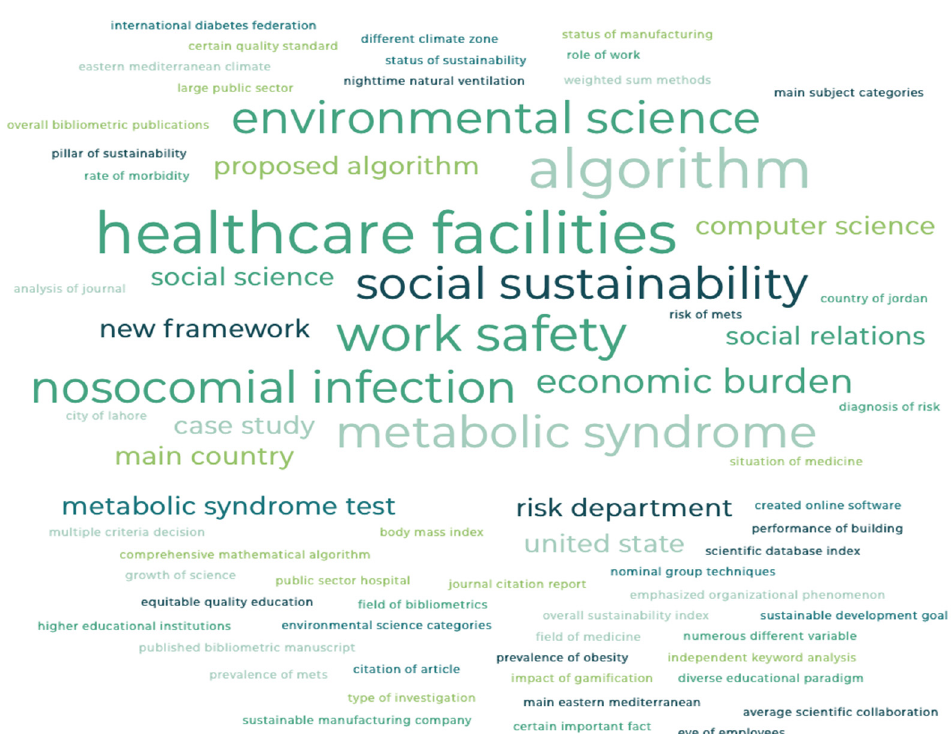
Figure 1. Word cloud of most relevant and frequent terms from the researchers in the Special Issue.